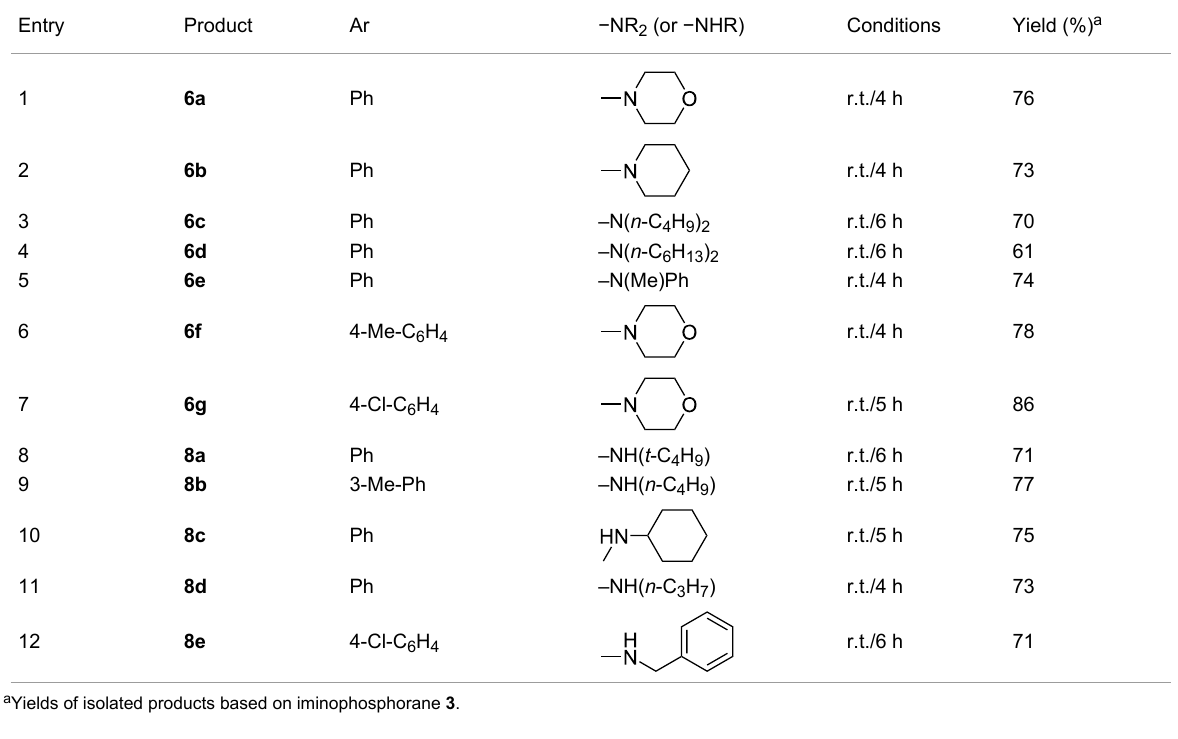
a Yields of isolated products based on iminophosphorane 3